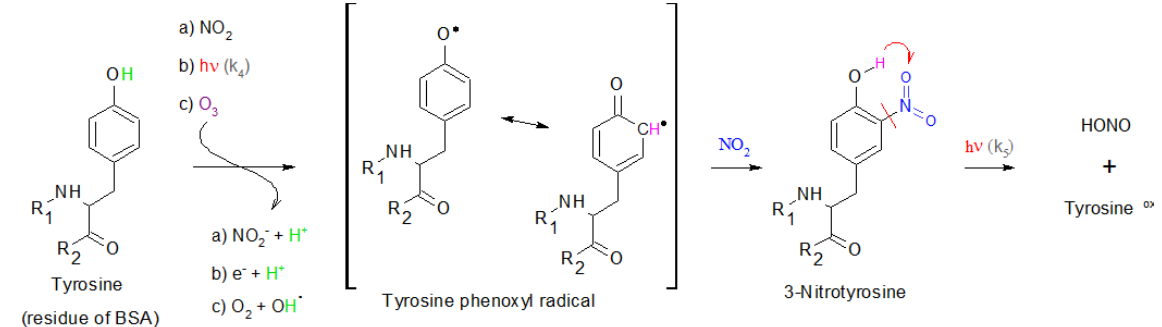
Figure 1. Overview on possible reaction mechanisms of atmospheric BSA nitration and subsequent HONO emission. The tyrosine phenoxyl radical intermediate is formed by the reaction of tyrosine with either (a) NO 2 , (b) light or (c) ozone. A second reaction with NO 2 forms 3- nitrotyrosine (adapted from Houée-Levin et al., 2015, and Shiraiwa et al., 2012). Subsequent intramolecular H transfer initiated by irradiation decompose the protein and HONO is emitted (adapted from Bejan et al.,